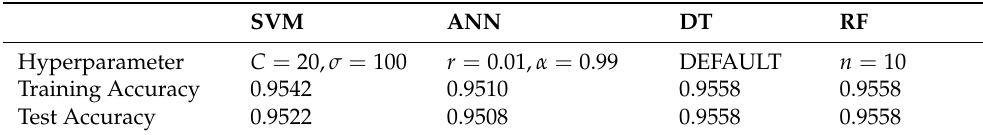
Table 12. Data4 optimal classification